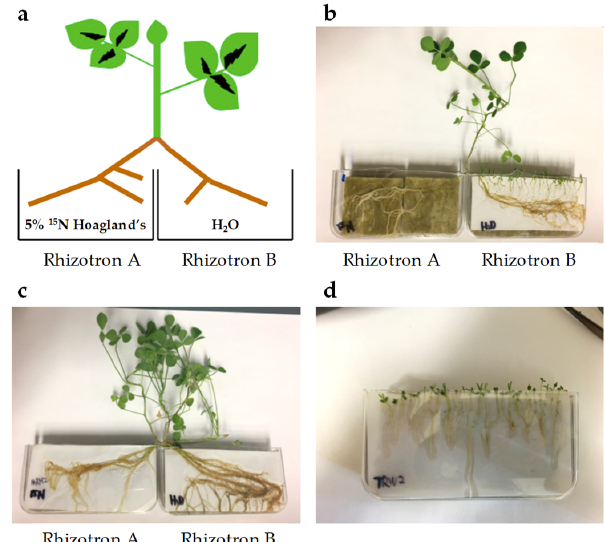
Figure 6. Split root system. ( a ) Diagram of split root system of 5 atom % 15 N labelled M. truncatula . ( b ) Triphysaria versicolor aligned with M. truncatula in rhizotron B (Tv-Attached and Mt-Infected, respectively). ( c ) M. truncatula grown on split rhizotrons without T. versicolor (Mt-Uninfected). ( d ) T. versicolor grown in their own in rhizotron given either water only or ¼ × Hoagland’s solution (Tv-Water or Tv-Hoagland’s, respectively).